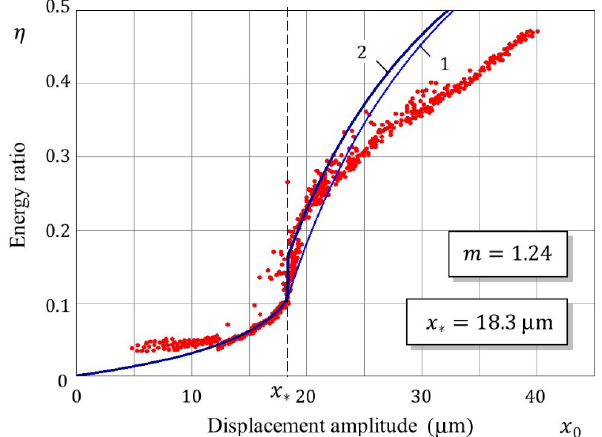
Fig. 8 Variation of the energy ratio  vs. the displacement x . Experimental data is according to Ref. [21]. Curve amplitude 0 1 is drawn based on the constant friction coefficient model; curve 2 takes into account a drop of the friction coefficient from 0.9 to 0.85 in the transition to